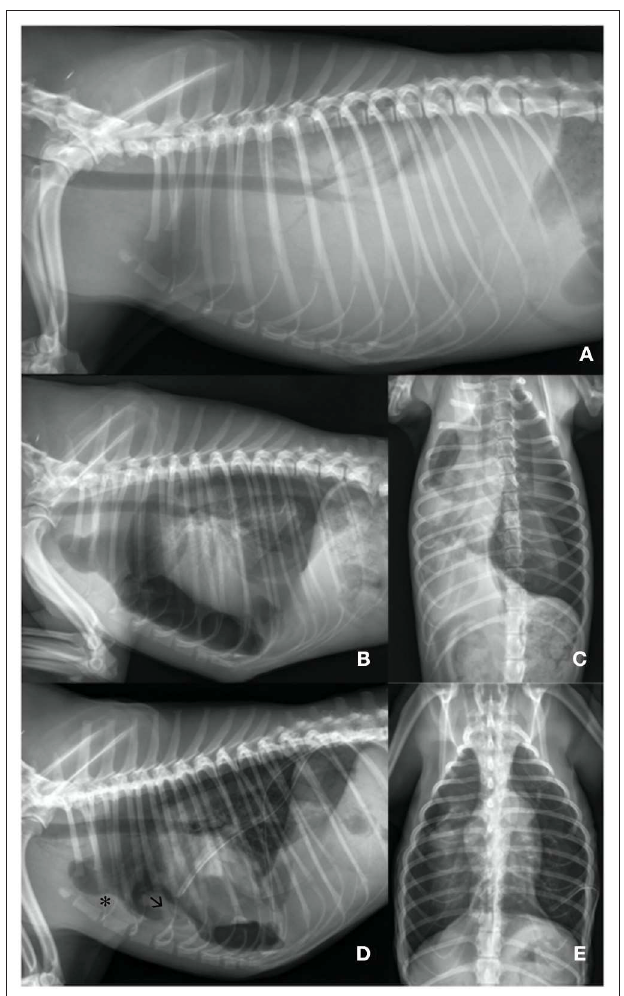
FIGURE 1 | (A) Day 1: Lateral left sided thoracic radiograph view: Markedly increased soft- tissue opacity with completely silhouetted cardiac silhouette and retracted lung lobes due to a severe pleural effusion. (B,C) Day 1: Lateral left sided and ventrodorsal thoracic radiograph view: After needle thoracocentesis lung lobes were severely rounded and expanded to ∼ 40%. Heterogenous pleural thickening is present. The heart is detached from the sternum. An iatrogenic pneumothorax was suspected. (D,E) Day 3: Lateral left sided and ventrodorsal thoracic radiograph view: Chest tubes are placed bilaterally. Lung lobes are re-expanded to 80% on the left and to 60% on the right side. Sternal lymphnode (asterisk) is prominent and a precardial mass-effect (arrow) is seen. The latter is suggestive for fibrotic